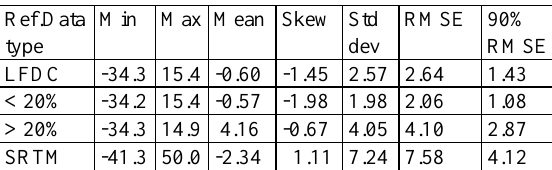
Table 5. Statistics obtained using difference DEM